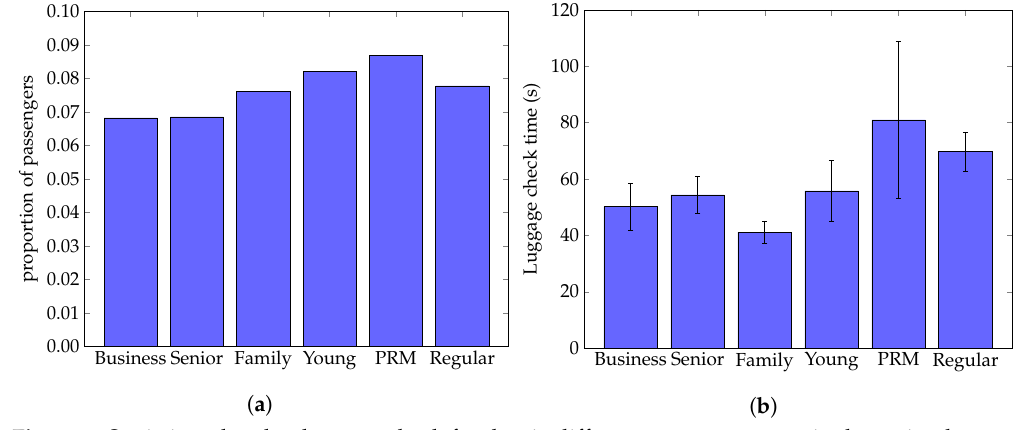
Figure 5. Statistics related to luggage check for the six different passenger types in the entire dataset. ( a ) The proportion of passengers that receive a luggage check. ( b ) The mean luggage check time of passengers, along with the standard